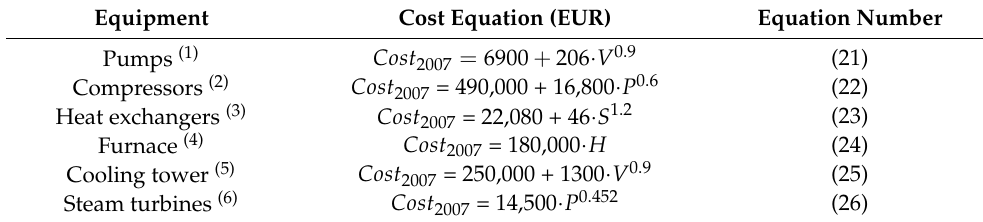
43.1 greater than